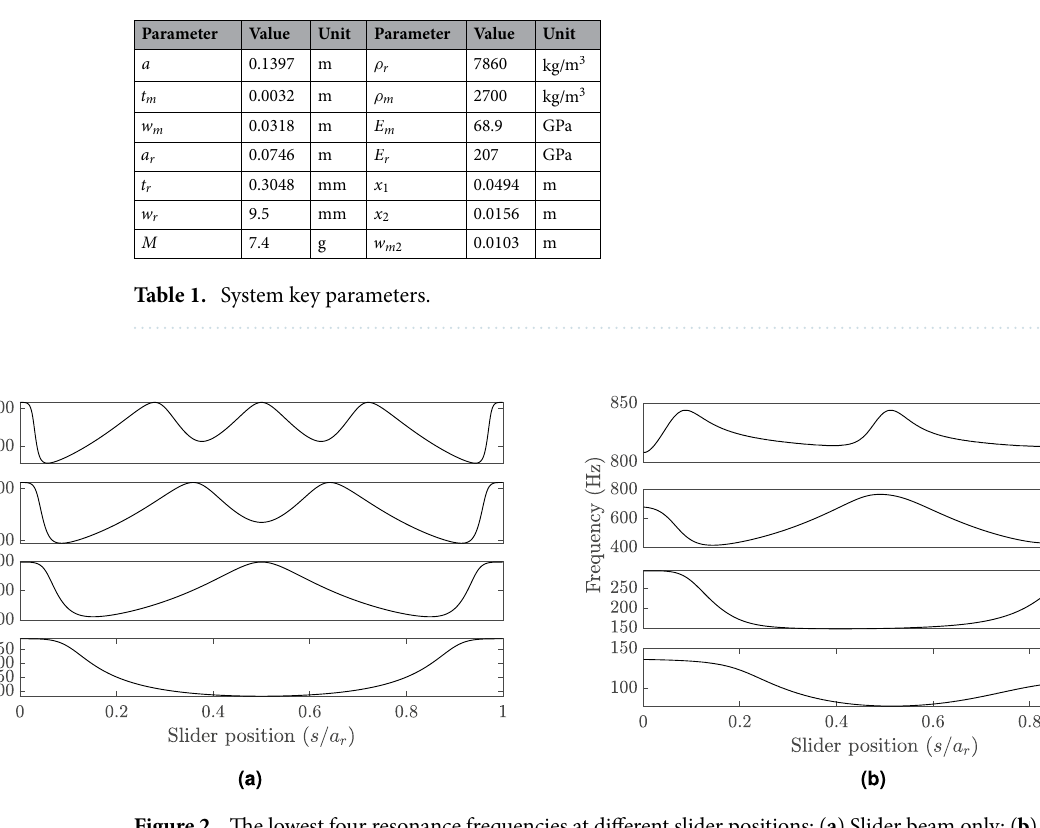
Figure 2. The lowest four resonance frequencies at different slider positions: ( a ) Slider beam only; ( b ) combined